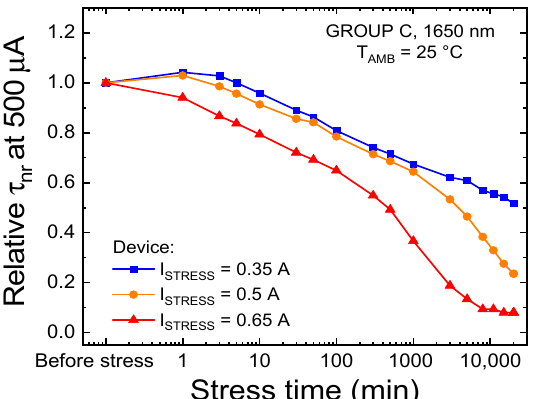
Figure 9. Relative trend of the non-radiative lifetime, extrapolated from the external quantum efficiency (EQE) calculated at 500 μ A and T AMB = 25 °C, during the three constant-current stresses carried out on group C LEDs at T SRESS = 45 °C.